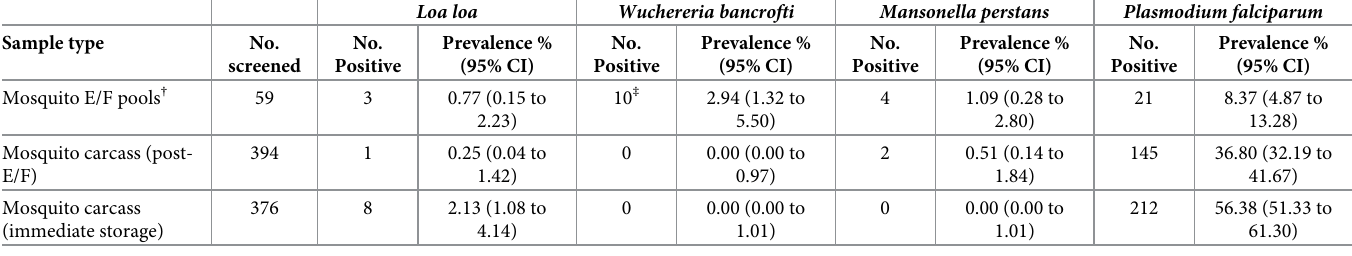
Table 1. DNA detection rates of L. Loa; W. bancrofti; M. perstans and P. falciparum in the carcasses of mosquitoes stored immediately, the carcasses of mosquitoes stored after a 36-hour E/F collection window, and in collected E/F